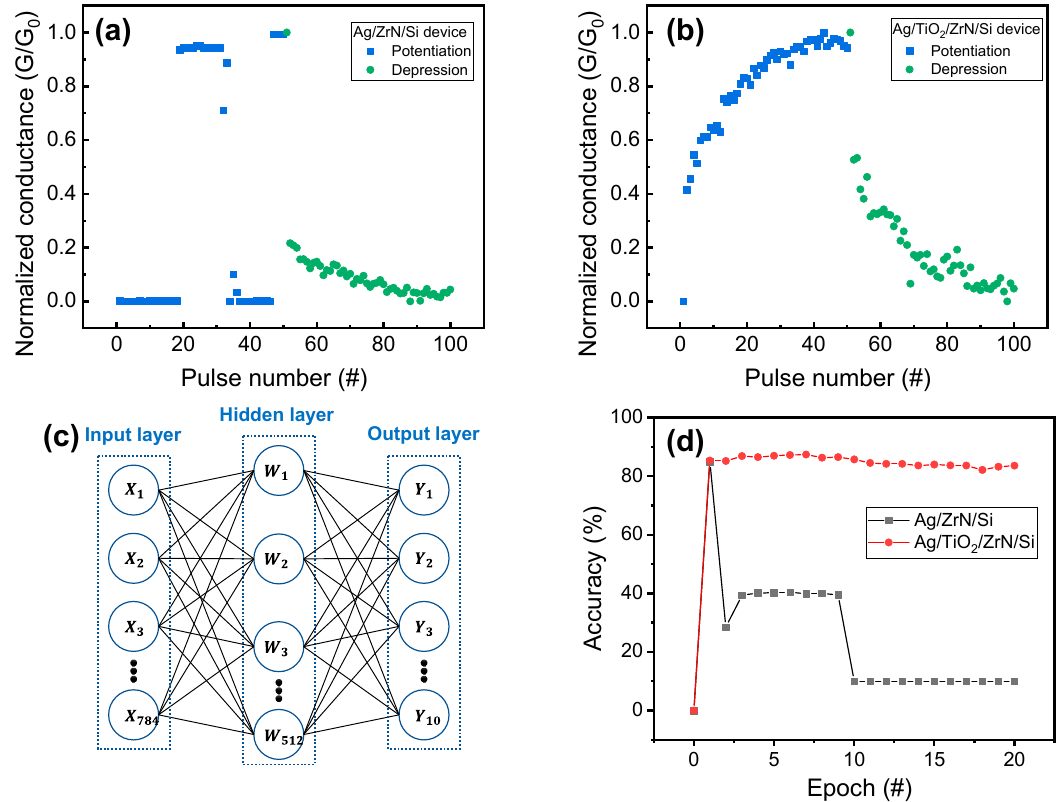
Figure 7. Potentiation and depression of ( a ) Ag/ZrN/Si device and ( b ) Ag/TiO 2 /ZrN/Si device; ( c ) neural network for the pattern recognition accuracy; ( d ) accuracy of Fashion Modified National Institute of Standards and Technology (Fashion MNIST) when applying normalized conductance values, such as synapse array, in a neural network for Ag/ZrN/Si and Ag/TiO 2 /ZrN/Si devices.